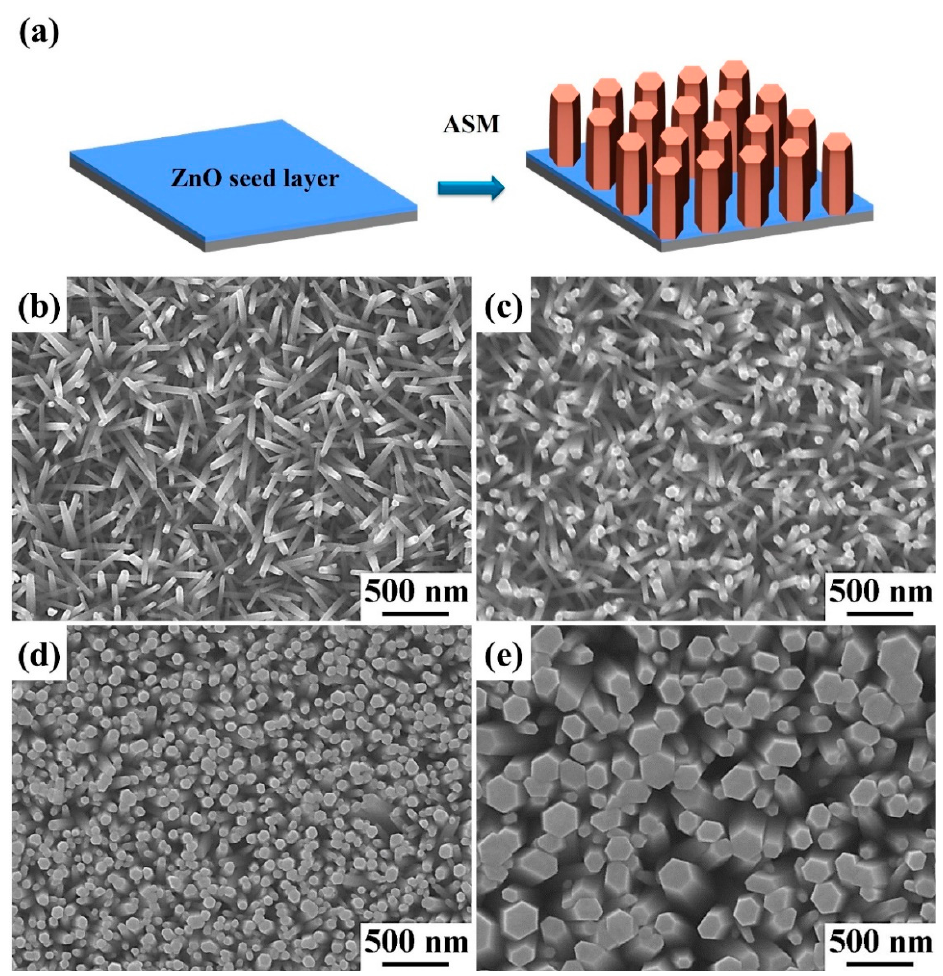
Figure 2. ( a ) Schematic diagram of the reaction processes for the growth of ZnO nanowires. ( b – e ) The top-view FESEM images of ZnO nanowires synthesized on the glass substrate with a ZnO seed film at different concentrations of ZnO precursors. The concentrations of ZnO precursors are ( b ) 10, ( c ) 25, ( d ) 50, and ( e ) 75 mM, respectively.